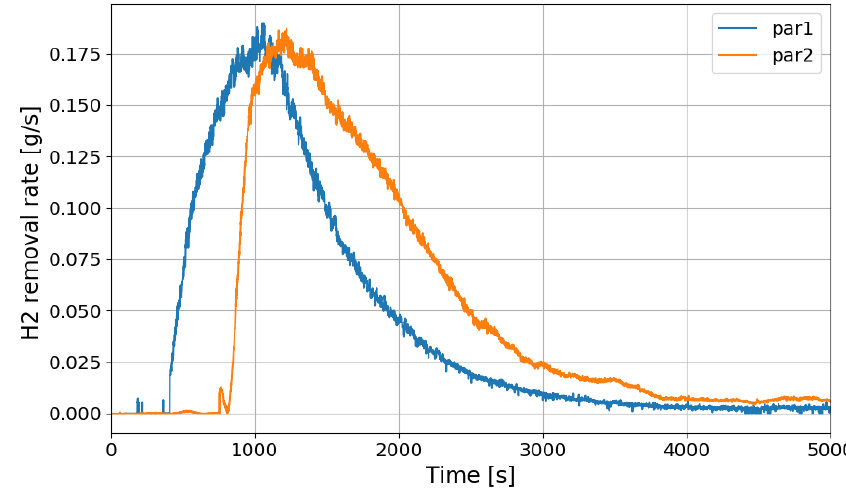
Figure 23. Change of hydrogen removal rates of the PARs in the SP5 test.